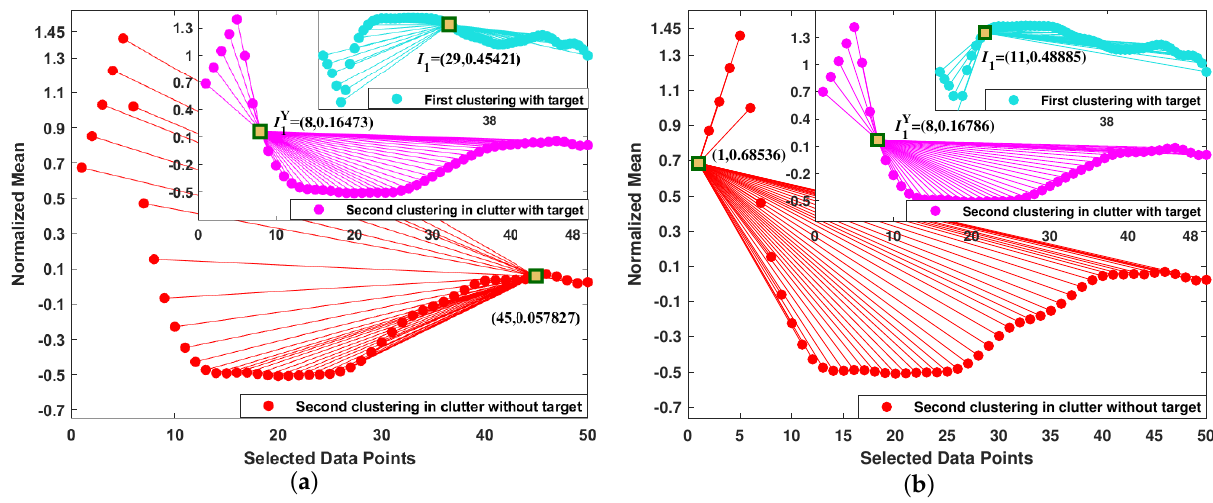
= ( 45,0.057827 ) in clutter 1